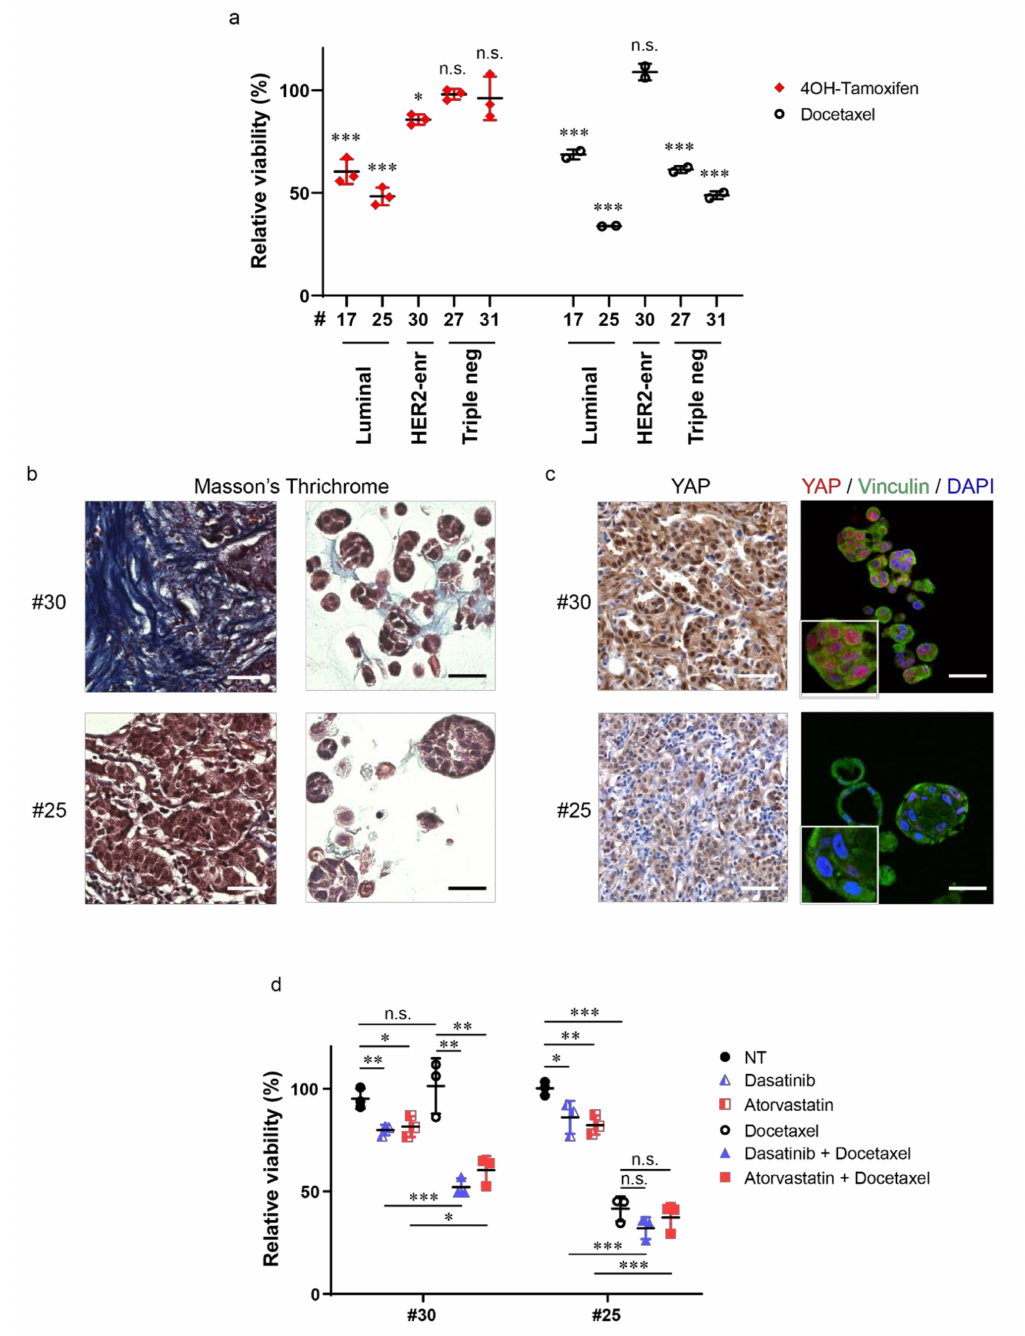
Figure 4. Tumor organoids represent a powerful model to evaluate novel potential therapeutic strategies. ( a ) Dot plot showing relative viability of BC organoids treated with either 10 µ M 4-Hydroxytamoxifen (4OH-Tamoxifen) or 1 nM Docetaxel for 7 days. Data are normalized to control treatment (solvent), set to 100%. Ethanol was used as control for 4-Hydroxytamoxifen, while dimethyl sulfoxide (DMSO) was used for Docetaxel. Data shown are the means ± s.d. of n = 3 (4OH-Tamoxifen) and n = 2 (Docetaxel) independent experiments; * p < 0.05, *** p < 0.001; n.s., not significant; t -test, using the Holm–Sidak method. ( b ) Representative images of Masson’s trichrome staining on sections of BC (left) and